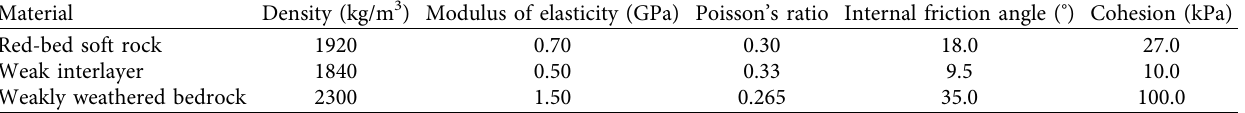
Table 3: Physical and mechanical parameters of rock and soil mass.